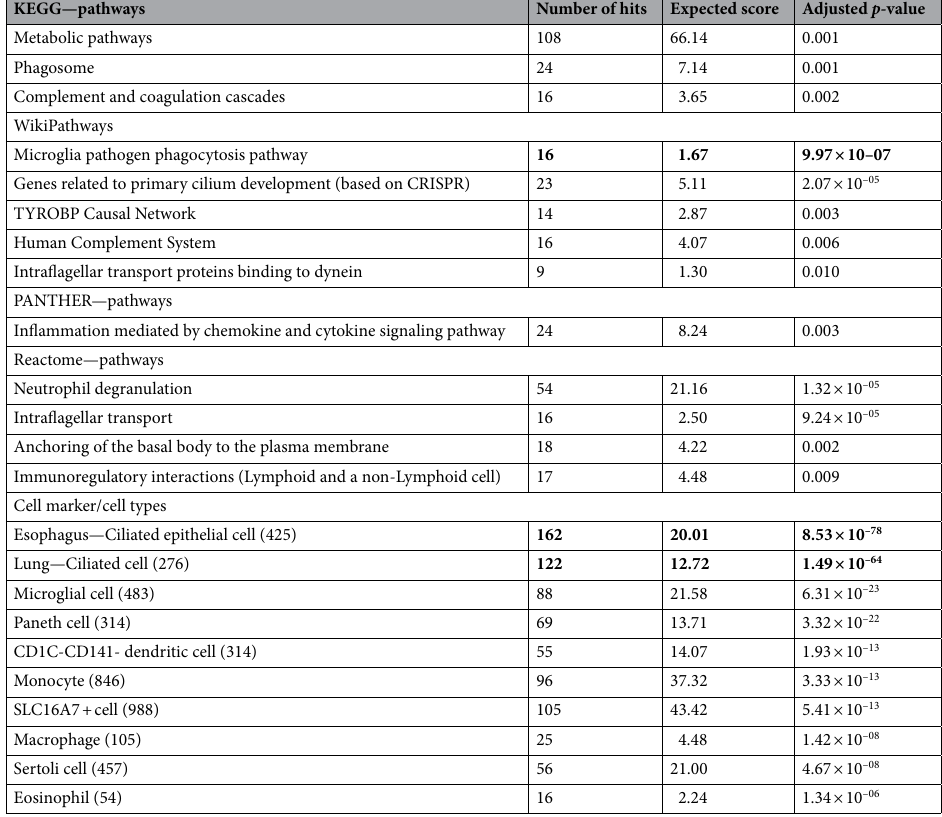
Table 2. Enriched pathways among the top 1698 differentially expressed genes (DEGs) from the DESeq2 analysis of polyp versus adjacent non-polyp mucosa in the same CRSwNP patient. Analyzed using Genetrail 3.029 p -values adjusted using the Benjamini-yekutieli method. (Genes p -value adjusted < 0.001, n = 1698). Significant values are in